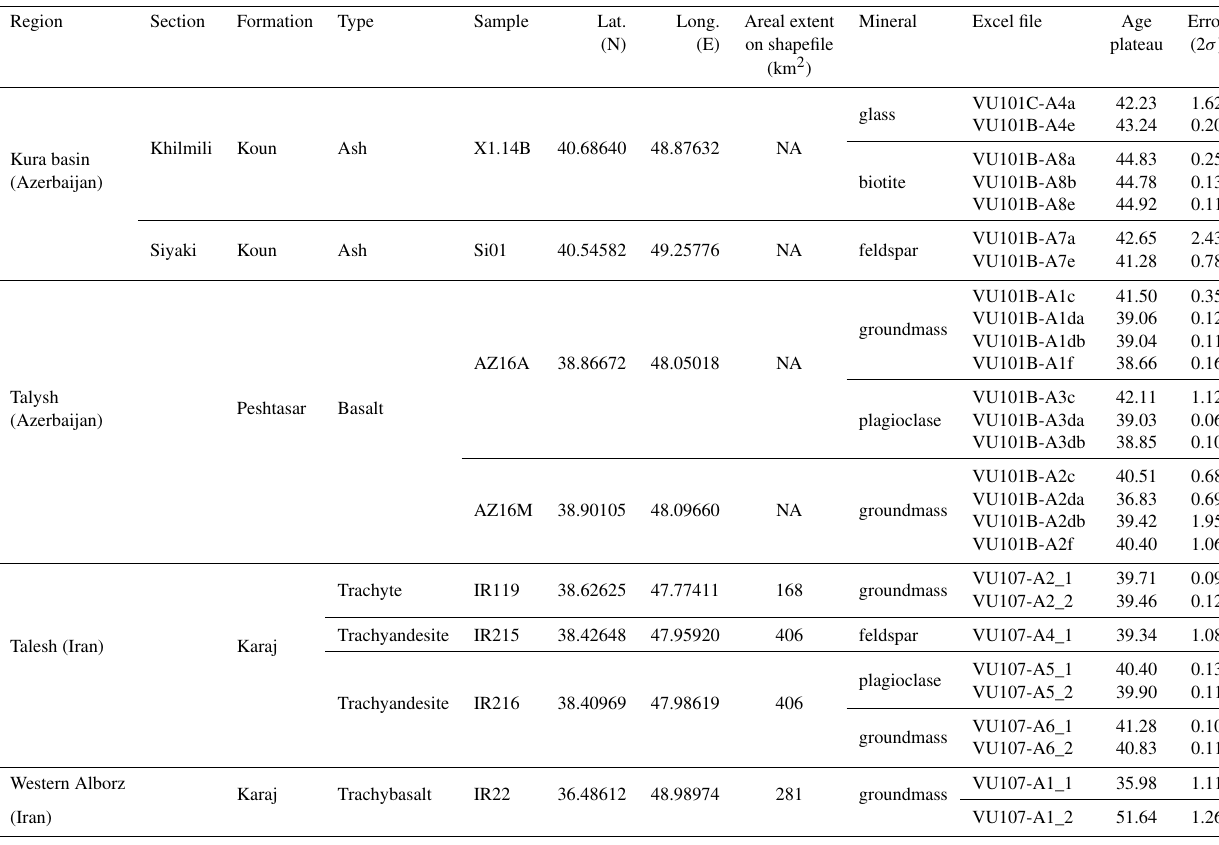
Table 1. Details of samples for Ar − Ar dating. Region Section Formation Type Sample